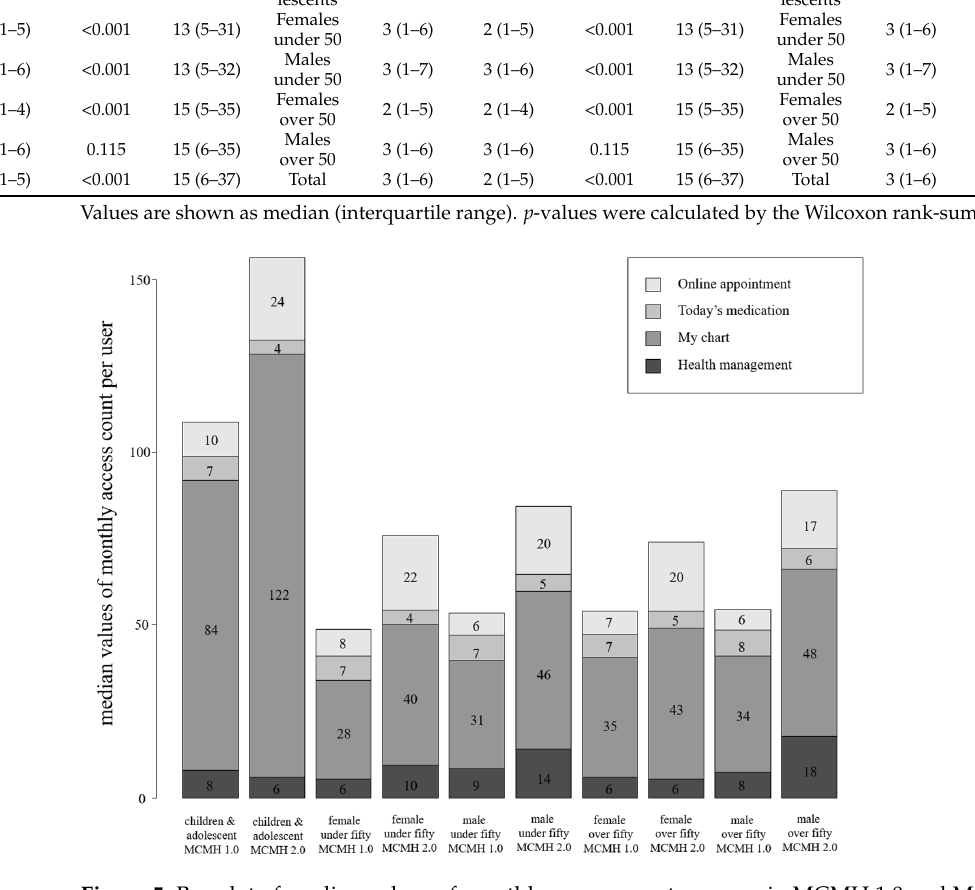
Table 6. Generalized estimating equation analysis including interaction effect according to menu effect and version.